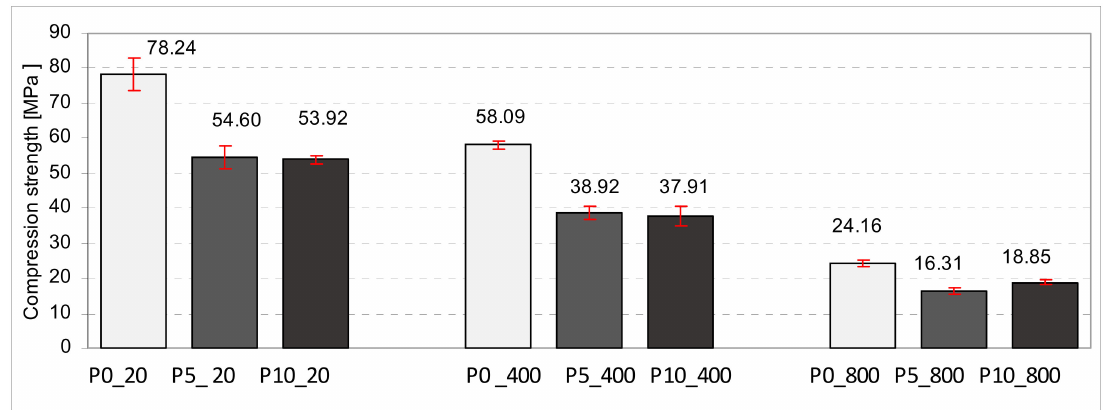
Figure 10. The average values with standard deviations of compression strength of cubic samples containing Portland cement.